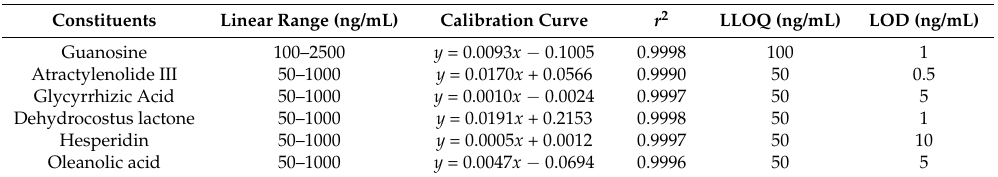
Table 2. Linear ranges, calibration curves, correlation coefficients ( r 2 ), and detection limits of six constituents using HPLC–MS.